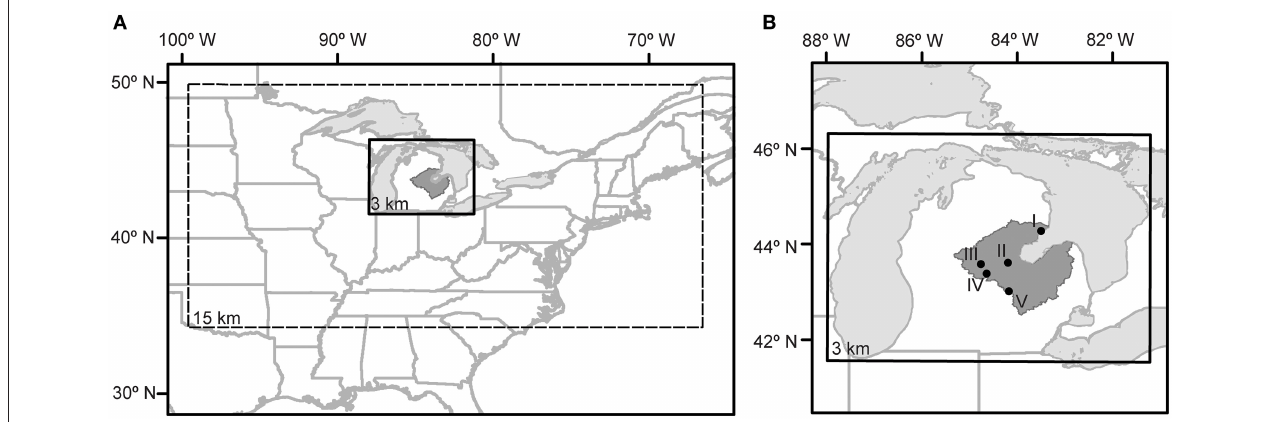
FIGURE 1 | Study area. (A) WRF downscaled domains, outer domain (dashed line) and inner domain (solid line). (B) Location of in-situ weather stations in relation to the Saginaw Bay Watershed: I. East Tawas/Oscoda, MI; II. Midland, MI; III. Mount Pleasant, MI; IV. Alma/Gratiot, MI; and V. Owosso,